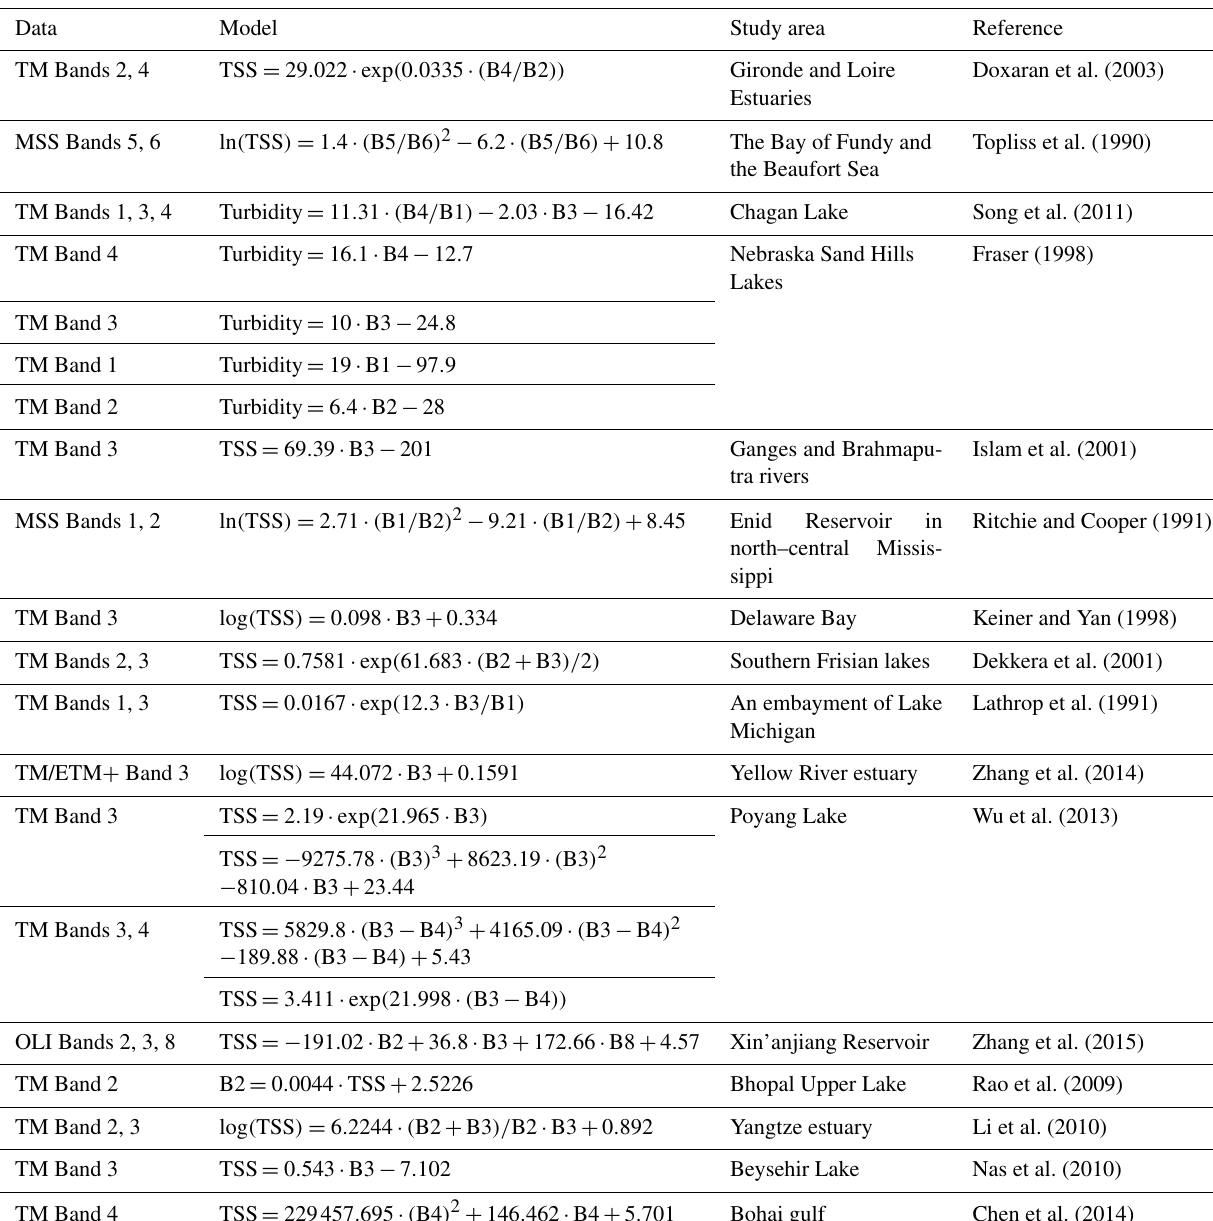
Table 2. Review of previous TSS or turbidity retrieval models using Landsat